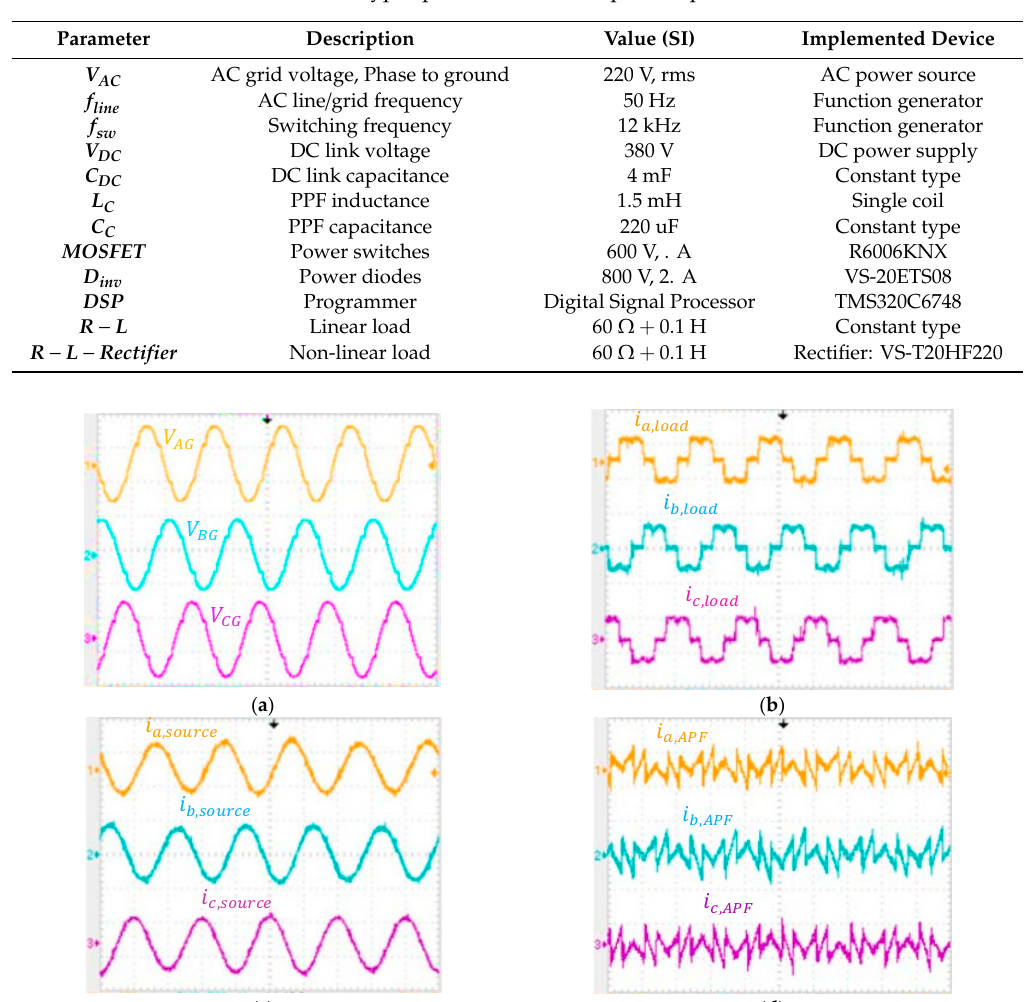
Figure 6. Experimental results at normal condition; ( a ) three-phase line-to-ground load voltages [volt/div: 220 V and time/div: 10 ms], ( b ) three-phase load currents [Amp/div: 6 A and time/div: 10 ms], ( c ) three-phase source currents [Amp/div: 6 A and time/div: 10 ms], ( d ) three-phase APF current injected to the load [Amp/div: 6 A and time/div: 10 ms].